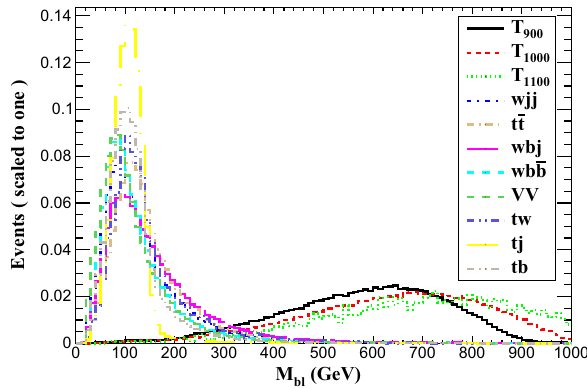
Fig. 6 Normalized invariant mass distribution of b (cid:5) system for the signals and